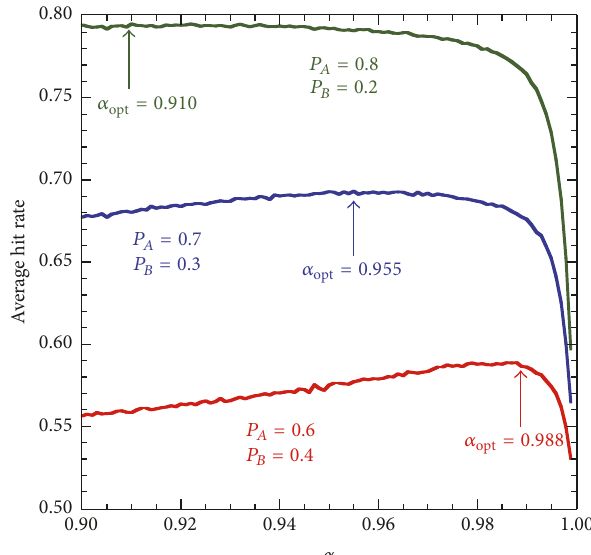
Figure 9: Average hit rates (AHR) for three different combinations of the hit probabilities of the two slot machines [(i) 𝑃 𝐴 = 0.8 and 𝑃 𝑃 𝑃 𝑃 𝑃 𝐵 = 0.2, (ii) 𝐴 = 0.7 and 𝐵 = 0.3, and (iii) 𝐴 = 0.6 and 𝐵 = 0.4] and their dependencies on the memory parameter. 𝛼 opt indicates the optimal memory parameter that maximizes